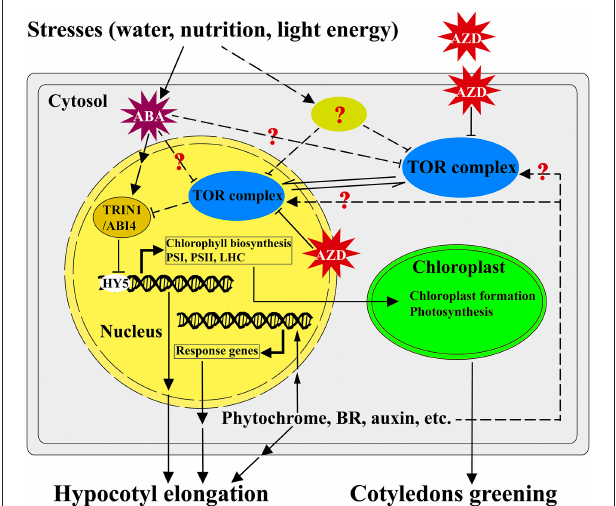
FIGURE 7 | A working model of TOR-TRIN1 pathway for modulating cotyledons greening. A simplified model shows how TOR regulates cotyledons greening through TRIN1 in Arabidopsis . In this model, AZD is able to suppress the kinase activity of TOR. TOR negatively regulates the stability of the TRIN1/ABI4 protein in nucleus. TRIN1 functions as a negative regulator of chloroplast biogenesis and hypocotyl elongation through inhibiting the activity of Elongated Hypocotyl 5 (HY5). Hypocotyl elongation could be regulated by phytochrome, hormones and other signals might or might not mediate via TOR signaling. Arrows and T-bars represent enhancement and inhibition, respectively. The solid lines indicate the known confirmed or direct interactions. The dashed lines indicate experimentally unproven or indirect